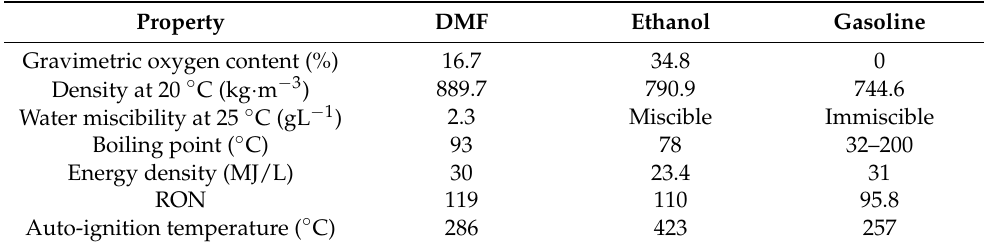
Table 1. Comparison of the fuel properties of DMF versus gasoline and ethanol. Adapted from [27]. Property DMF Gravimetric oxygen content (%)